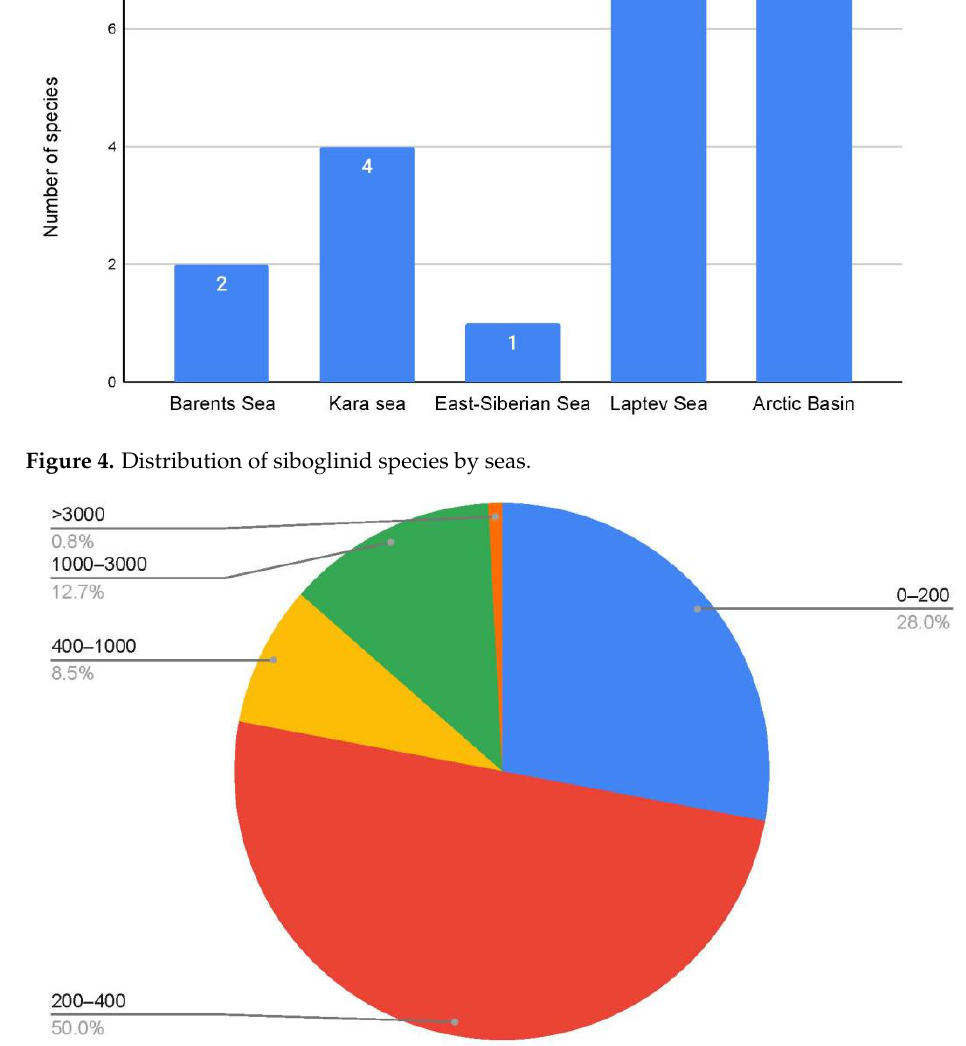
Figure 5. Percentage distribution of siboglinid records by depth.